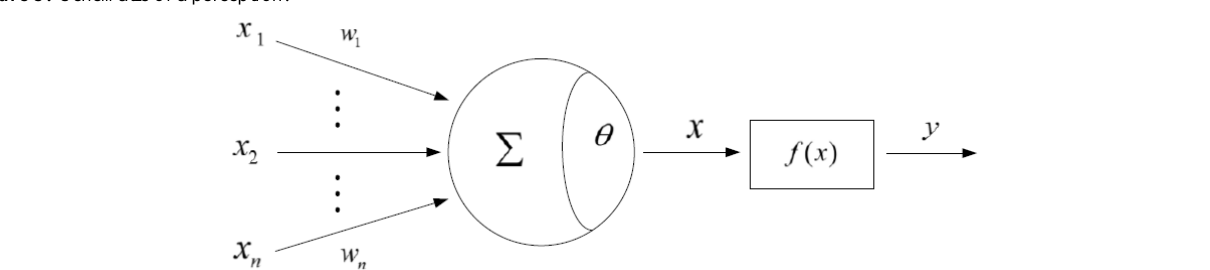
Figure 3. Schematic of a perceptron.